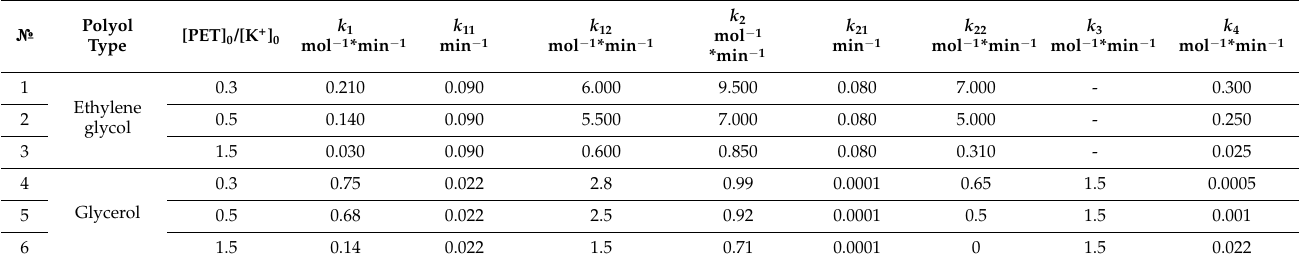
Table 2. Parameters of Equations (4)–(15) for PET depolymerization by KSt in pure